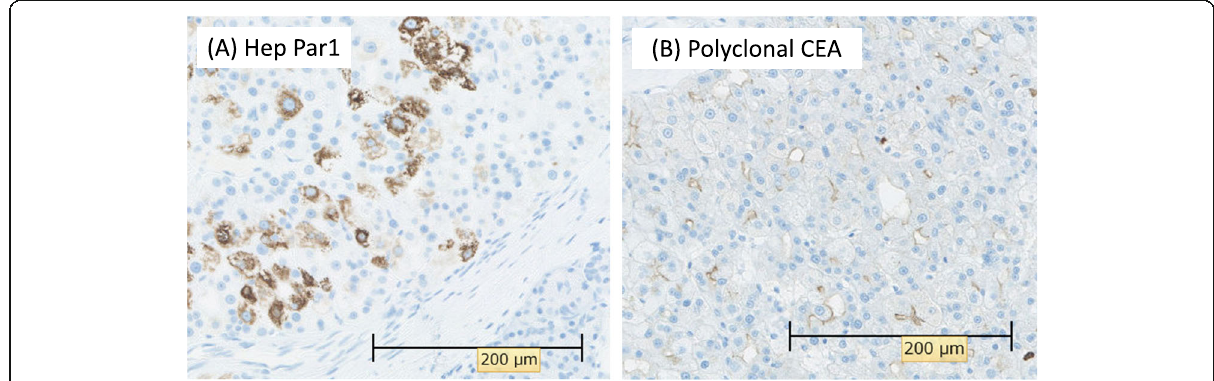
Fig. 5 Immunohistochemical staining findings. a The tumor cells were positive for hepatocyte paraffin 1. b The tumor cells were positive for polyclonal carcinoembryonic antigen (CEA). A canalicular pattern was confirmed on polyclonal CEA immunohistochemical